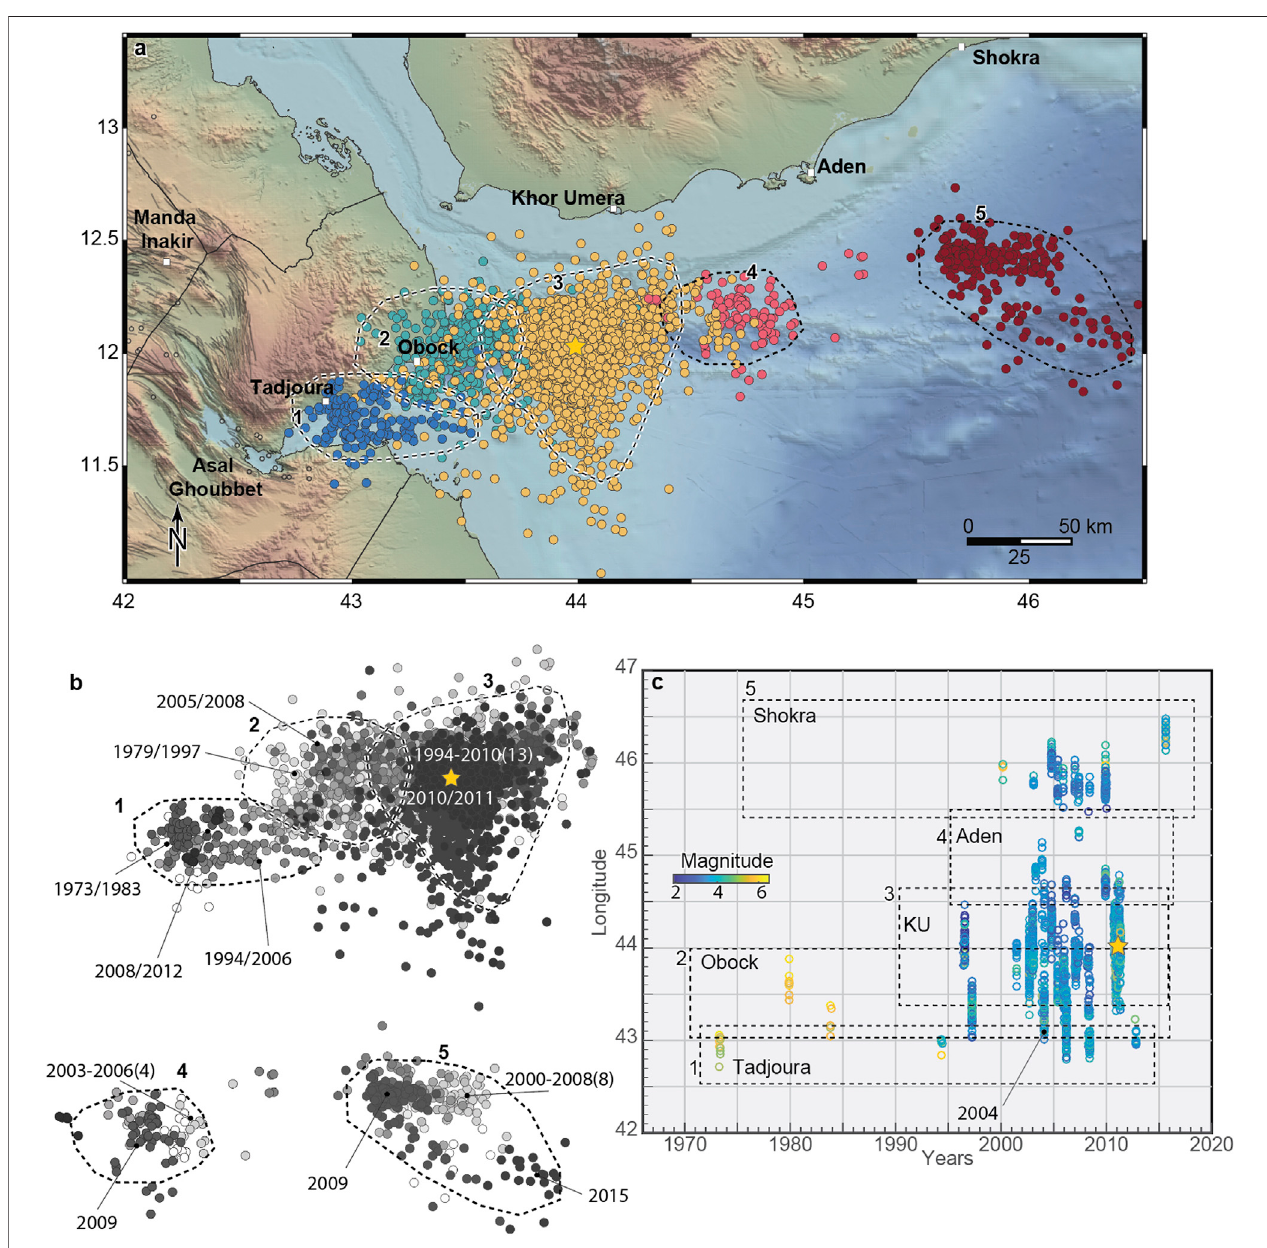
FIGURE7 | Earthquake swarms inthe Gulf ofAden from 1960 to2017. (A) Five different swarm areas (clusters) wereidenti fi ed in the Gulfof Aden, from theGulfof Tadjoura to the west of the town of Shokra (Yemen). (B) Each cluster consists of several earthquake swarms whose timing is indicated by the grey gradient from white (older events) to black (younger events). The larger earthquake swarms are marked by the year of occurrence with the number of swarms (in brackets) for the noted period. The yellow star shows the location of the 2010 submarine eruption. (C) Longitude location of the swarms as a function of time with colors indicating event